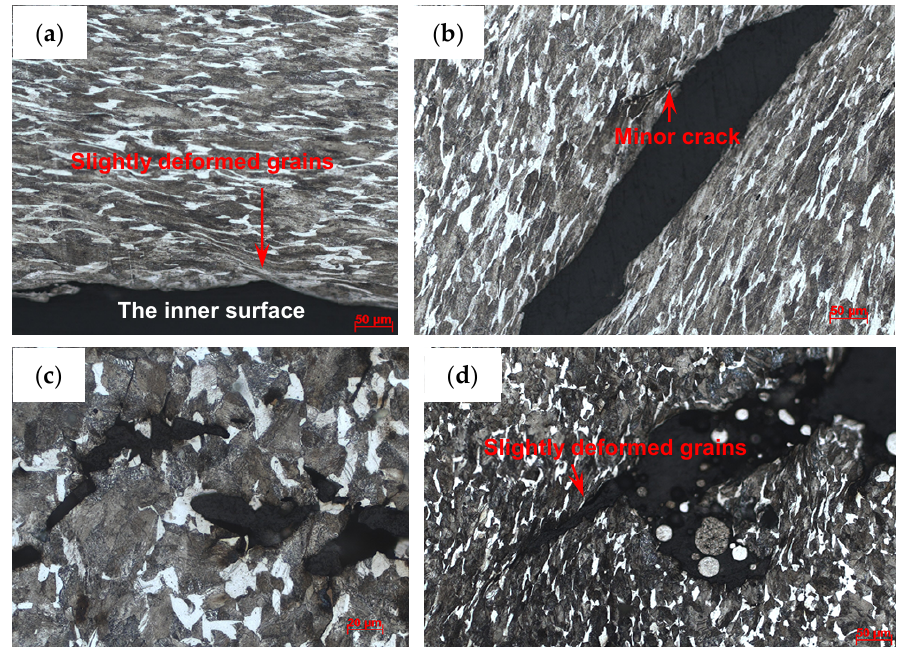
Figure 11. Typical results of optical microscope for Specimen 2#. ( a ) Slightly deformed grains near the inner surface; ( b ) minor crack within the big crack, which is the magnified region of the red circle in Figure 10c; ( c ) internal brittle microvoid damage, which is the magnified region of the blue square in Figure 10a; ( d ) internal ductile microvoid damage.